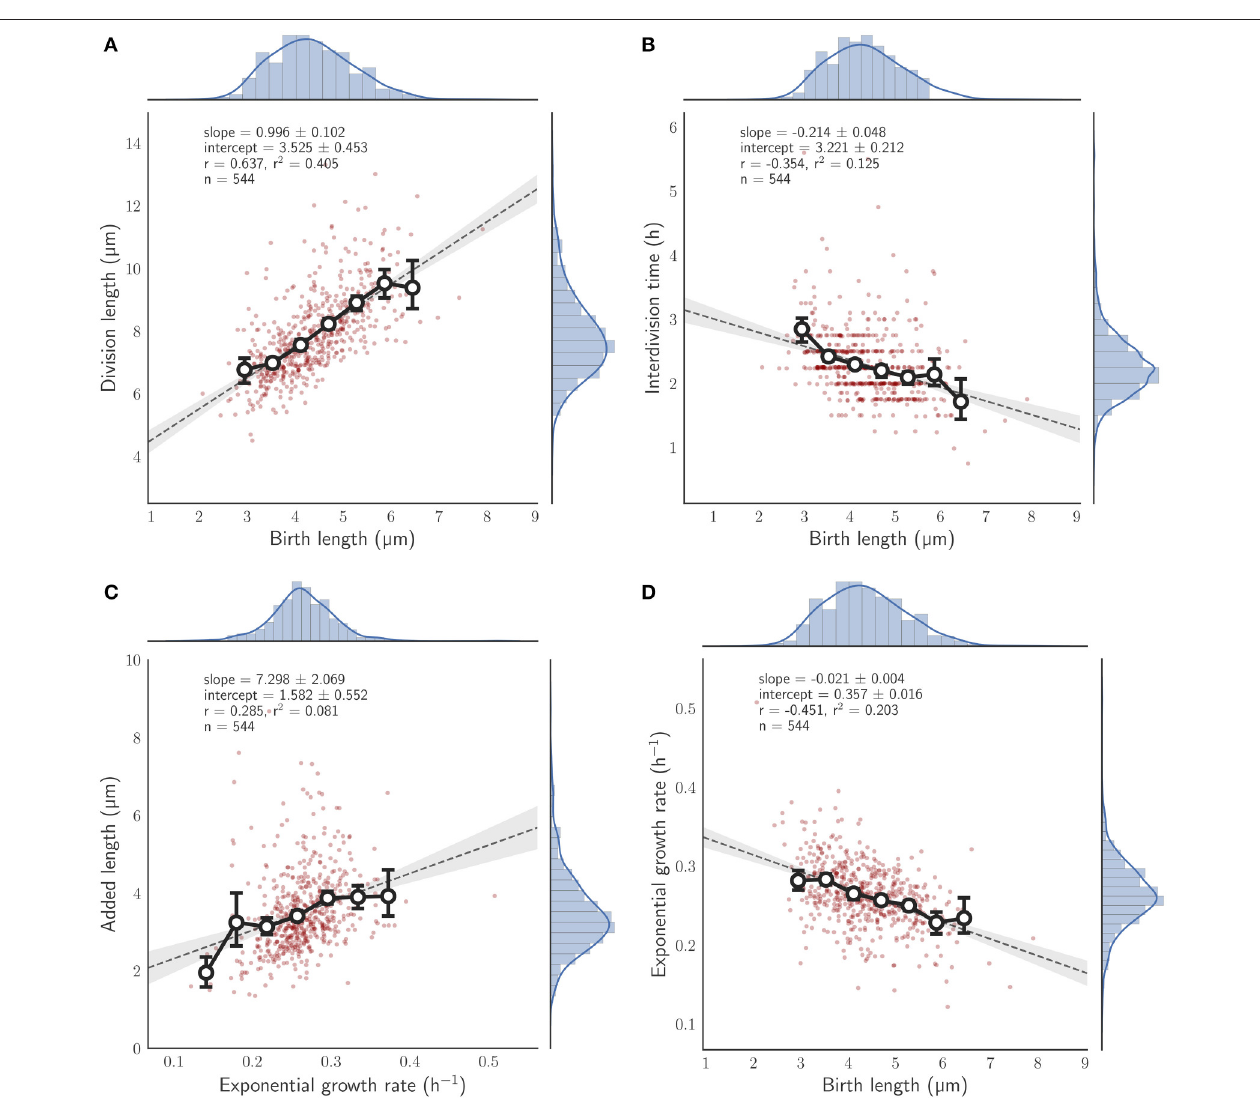
FIGURE 2 | Relationship between birth length and other single cell measures for single M. smegmatis cells grown with glycerol as a sole carbon source. Red circles, single cell measurements; histograms, distribution of individual cells, with kernel density estimates depicted as a blue line; solid line with white filled circles, mean of birth length bins with error bars denoting the 95% confidence interval of the estimate determined by bootstrapping; gray dotted line, the least squares linear regression fit of unbinned data; Key, slope —the slope of the regression line ( ± the 95% confidence interval), intercept —the y -intercept, r —the Pearson correlation coefficient, n —the total number of cells measured, (A) Division length is plotted against birth length. (B) Interdivision time against birth length. (C) Added length against exponential growth rate. (D) Exponential growth rate against birth